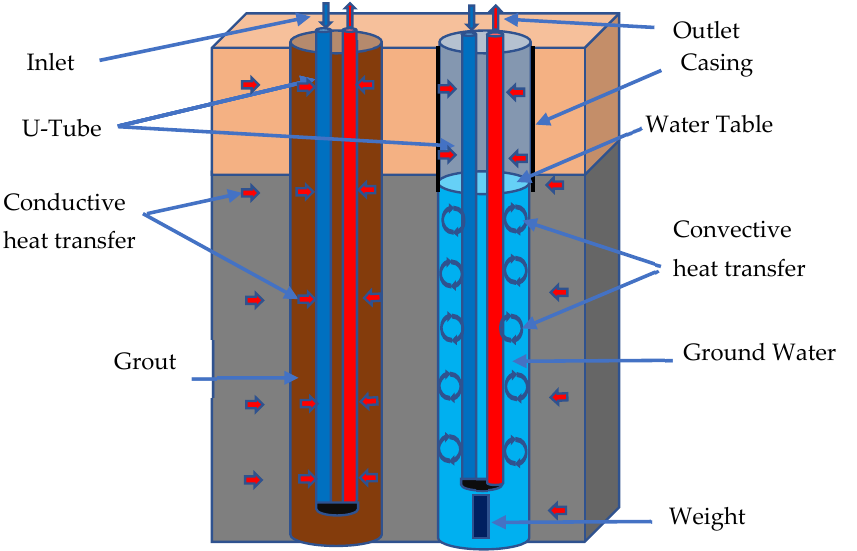
Figure 4. A water-filled borehole exchanger—Sweden practice ( right ), a BHE backfilled with grout —western practice ( left ).